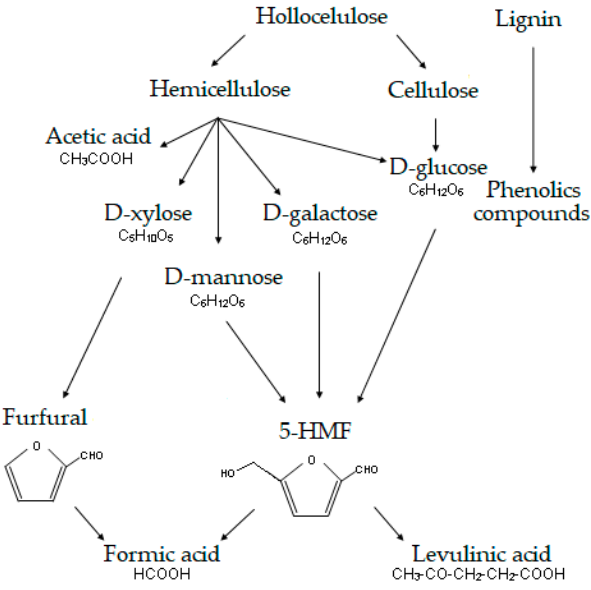
Figure 9. Products and by-products obtaining during the acid hydrolysis of lignocellulose biomass.